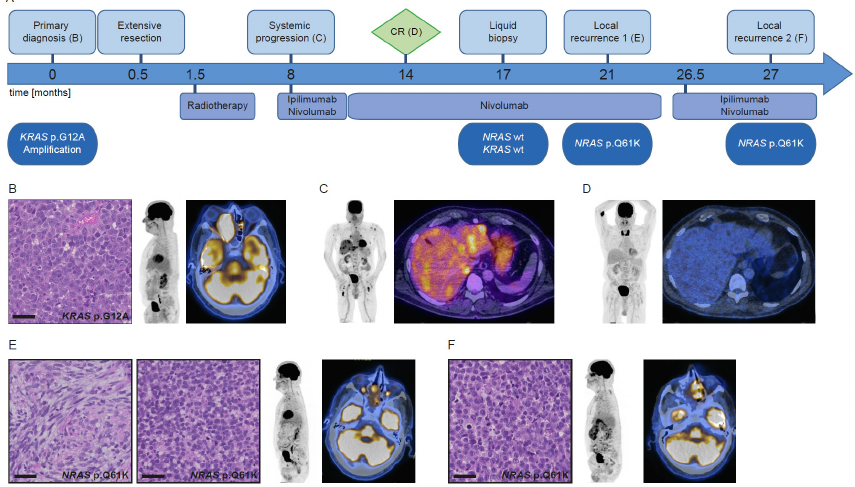
Figure 2. Course of disease, treatment, and morpho-molecular workup of patient 2. ( A ) Timeline. ( B ) Histology of the primary tumor; PET MIP display and fused PET/CT image at primary diagnosis. ( C ) PET MIP display and fused PET/CT image at the start of immunotherapy. ( D ) PET MIP display and fused PET/CT image at CR. ( E ) Histology of the first local recurrence, left: spindle cell shaped morphology, right: monomorphic epithelioid morphology; PET MIP display and fused PET/CT image at first local recurrence. ( F ) Histology of the second local recurrence; PET MIP display and fused PET/CT image at second local recurrence. Scale bar: 40µm. wt: wild type, CR: complete remission.